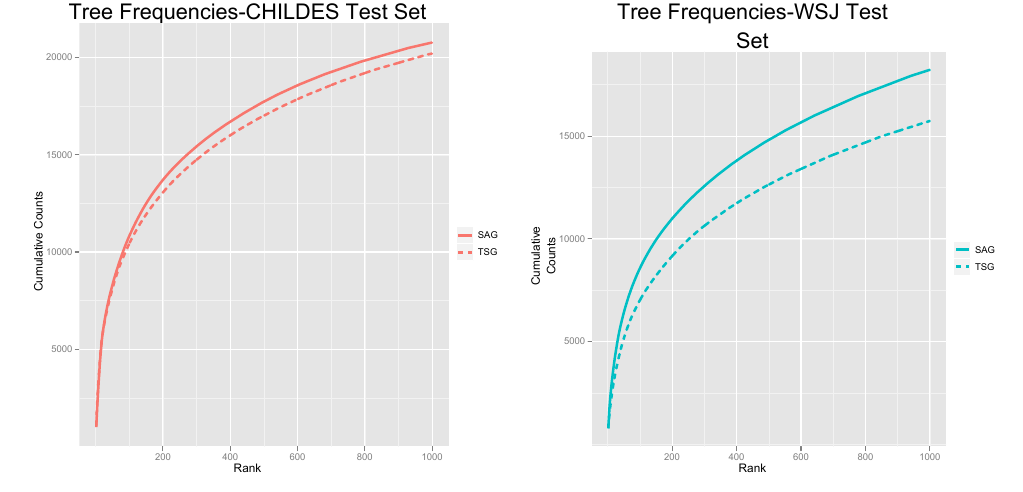
Figure 8: Cumulative frequencies (generalization) sentence after training. The analyses below are otherwise identical to those in the previous